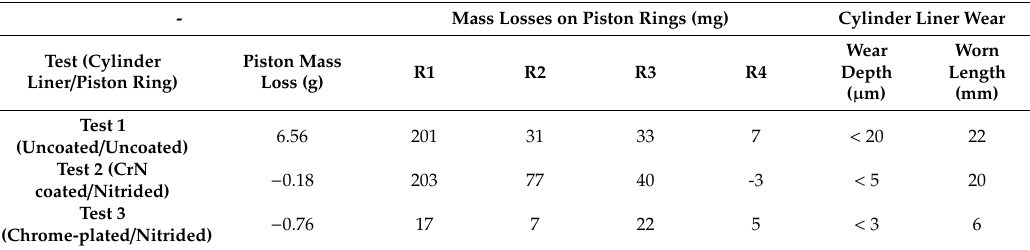
Table 5. Engine test: mass loss on pistons, piston rings and cylinder liners. - Mass Losses on Piston Rings